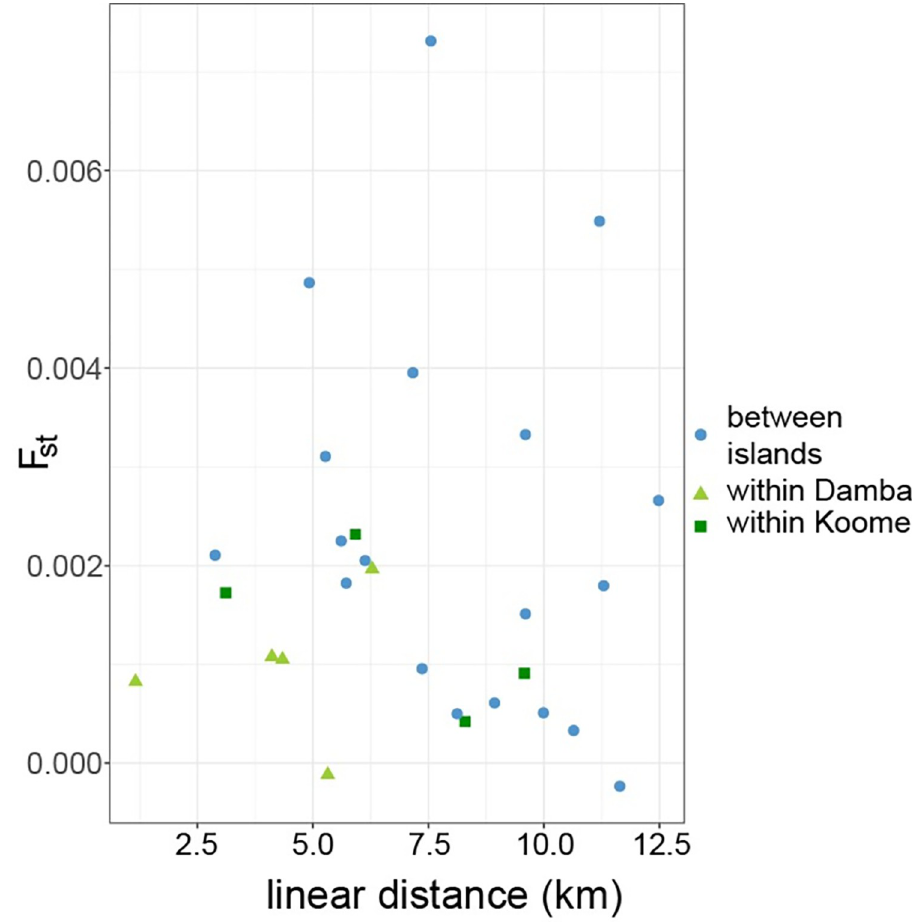
Fig 4. Pairwise F ST estimates do not vary with linear distances between villages. Weir and Cockerham F ST estimates used and distance measured in kilometres. Points show results of pairwise comparison between samples from different villages found on different islands or from different villages with Damba or Koome islands.